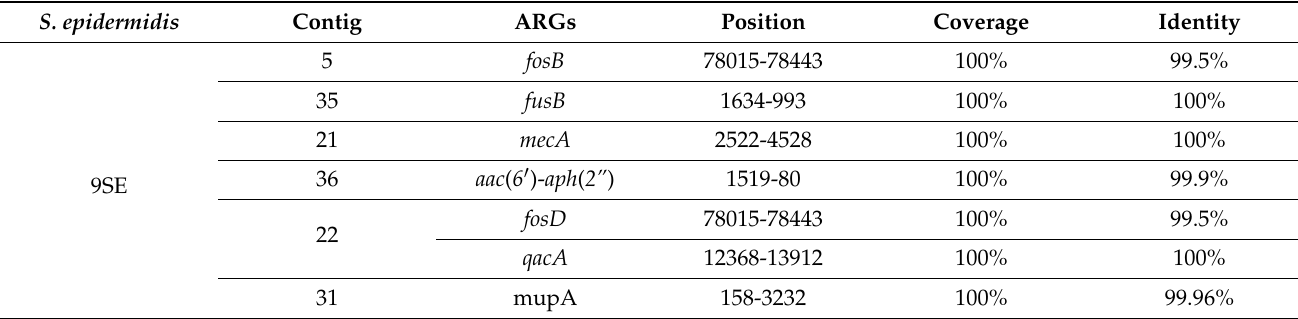
Table 5. Antimicrobial resistance genes present in S. epidermidis